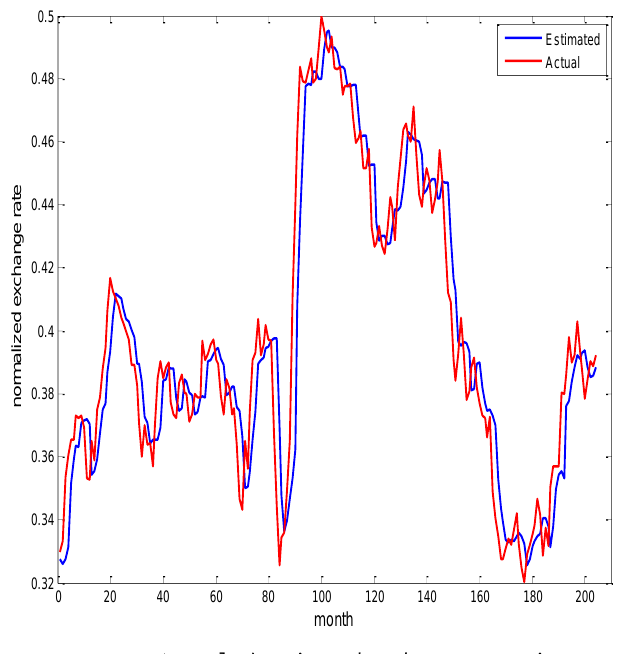
Figure 12 . Actual v/s estimated exchange rate prices for Pound/Dollar by combined method (error based)